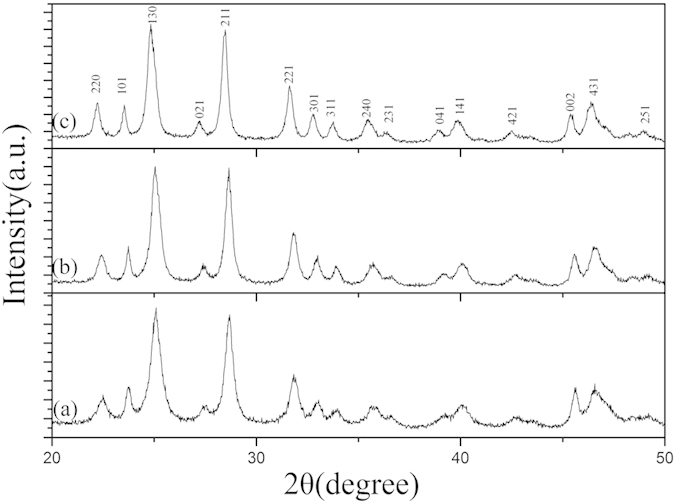
XRD patterns of Bi2S3: Eu3+ nanocrystals prepared at 180 °C for different reaction time: (a) 6 h, (b) 9 h, and (c) 12 h.